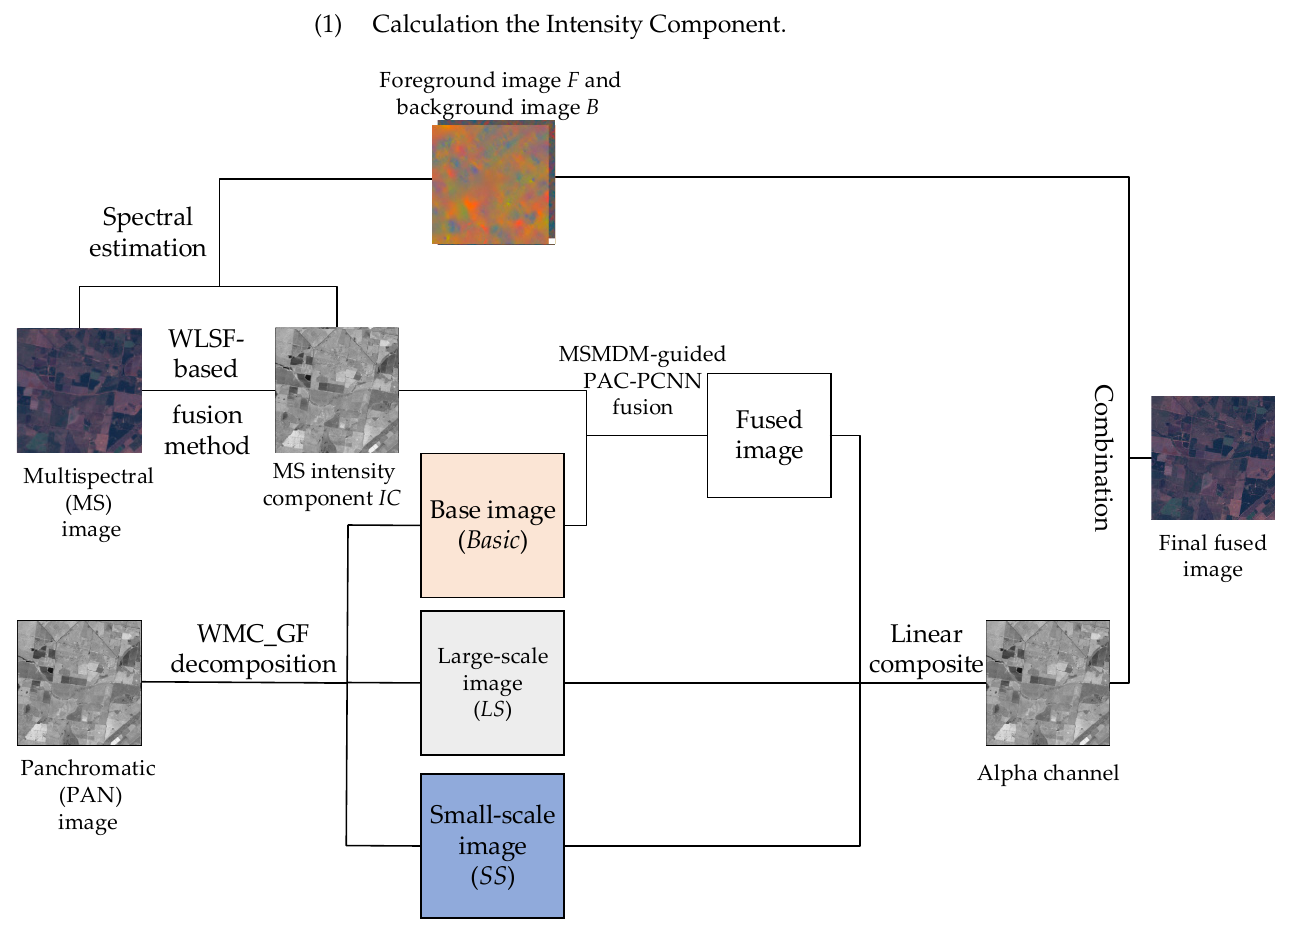
Figure 6. The fusion steps of the proposed method.